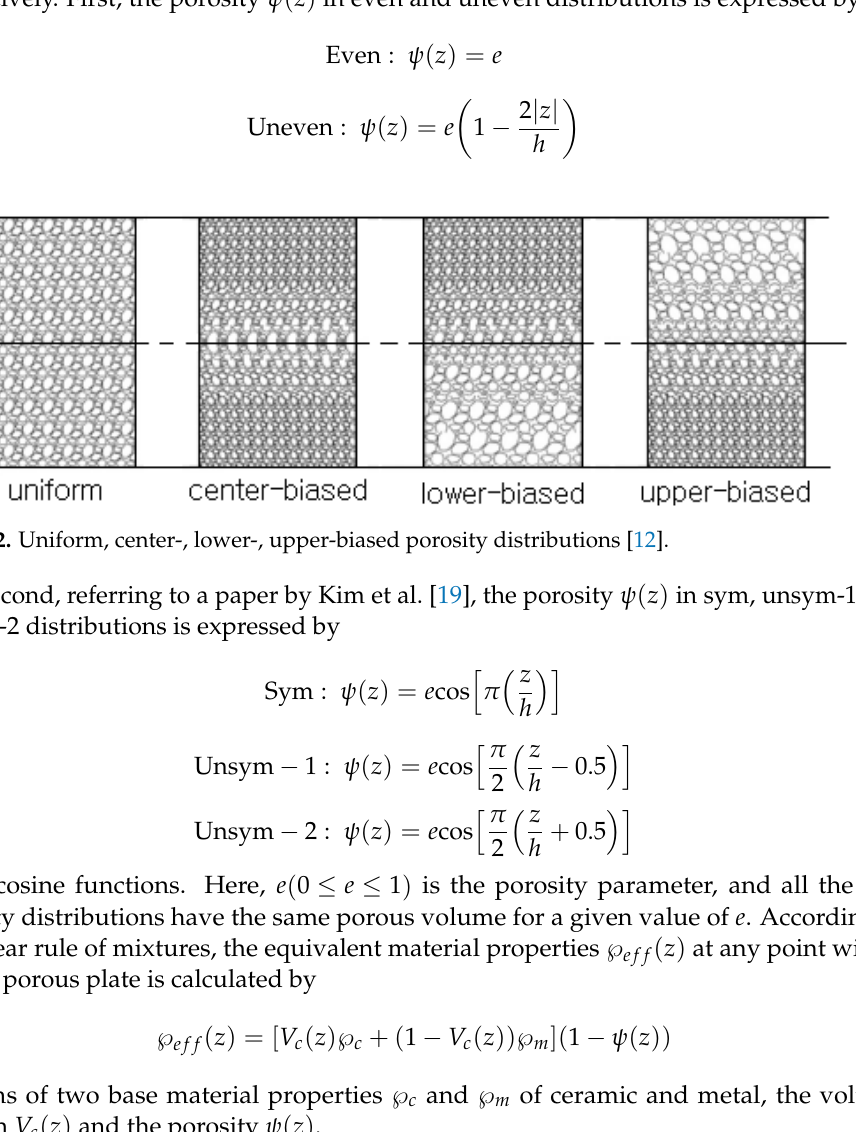
being the ceramic index. Figure 1b represents the thickness-wise ceramic volume fractions for different values of n , which were plotted using Excel. The plate becomes ceramic-rich as n approaches infinity. Figure 2 represents four different porosity distributions taken for the current study in which the porosity density changes in the